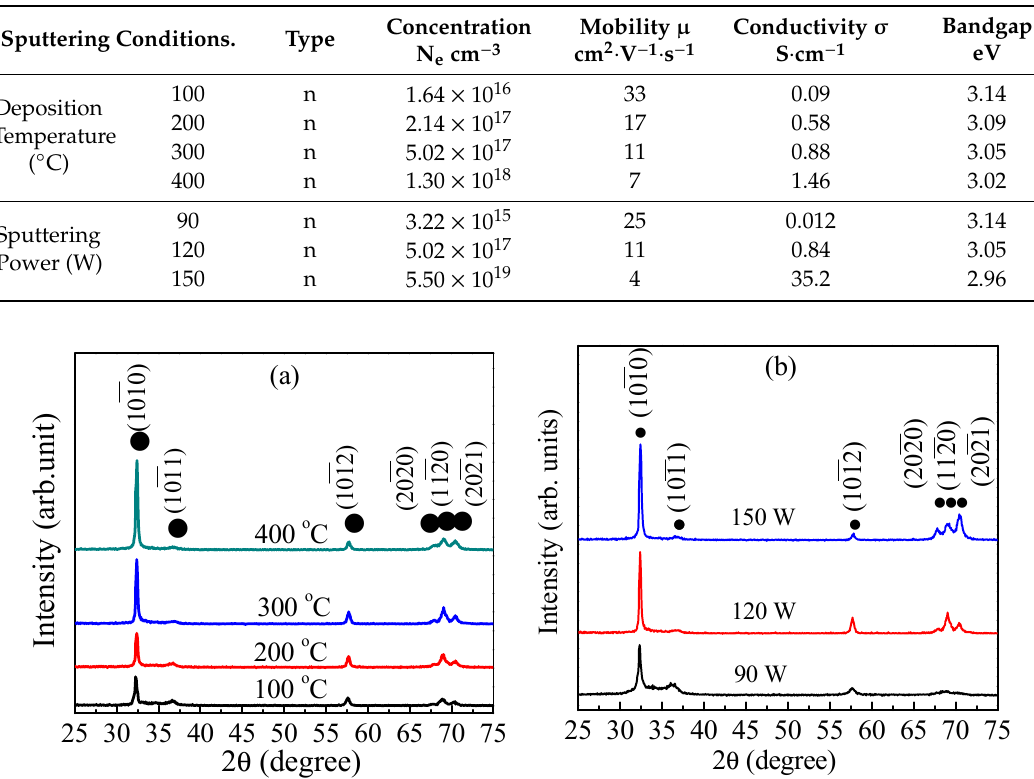
Figure 3. XRD patterns of Ge 0.07 GaN films deposited at ( a ) different growth temperatures; ( b ) different RF power (90–150 W) in an Ar/N 2 atmosphere.